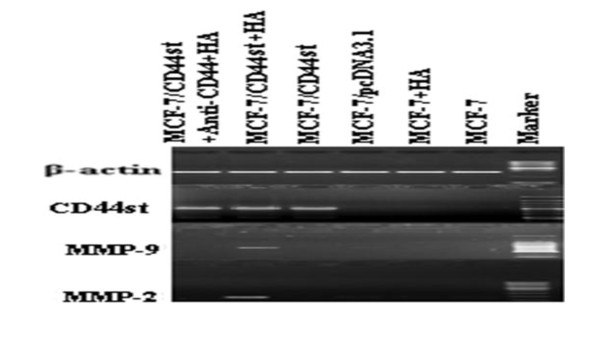
Expression of CD44st and expression of HA inducting MMP-2, MMP-9 mRNA. Cells treated with HA were cultured in serum free medium containing or without HA (100 μg/ml) for 24 h. The expression levels of MMP-2 and MMP-9 mRNA were measured by RT-PCR.